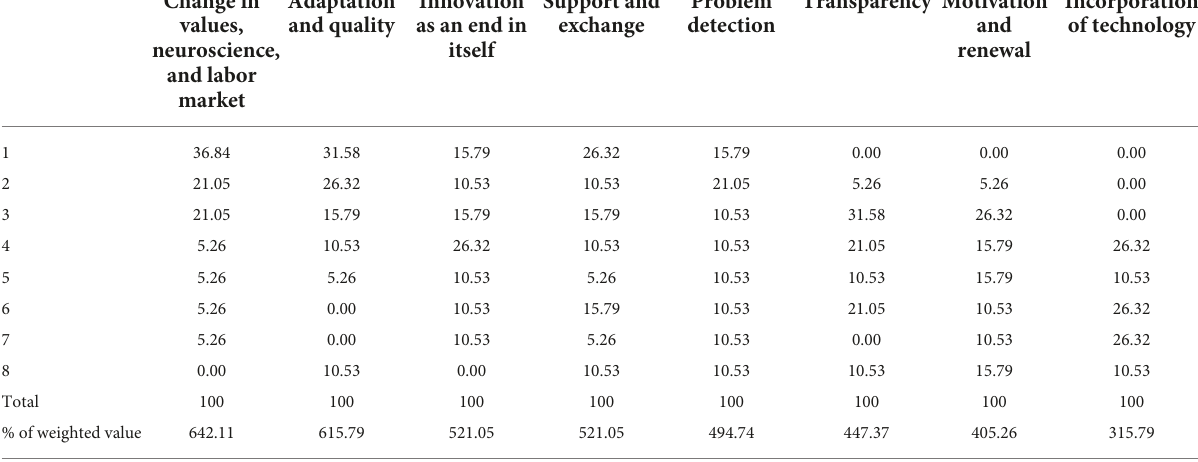
TABLE 12 Opinions on the promotion of educational innovation, from highest to lowest priority. Change in values,